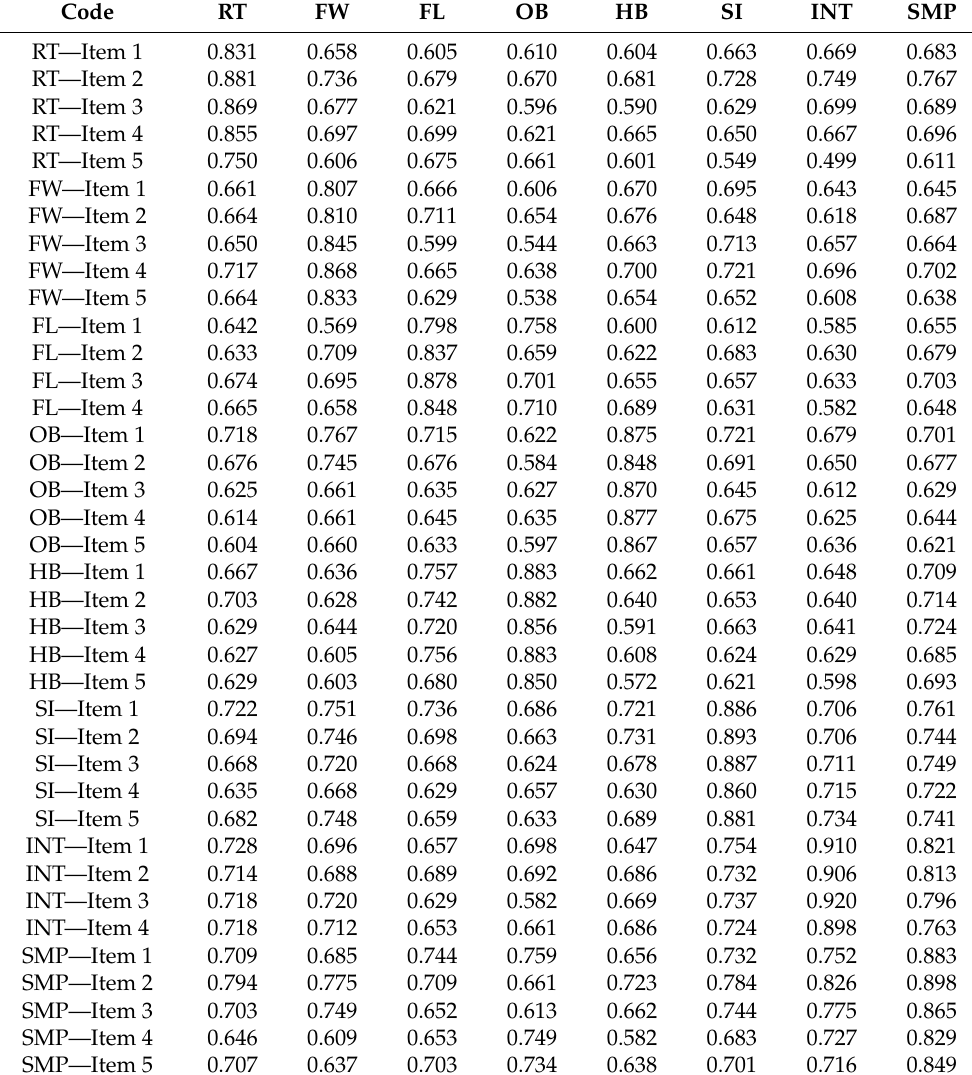
Table 4. Loadings and